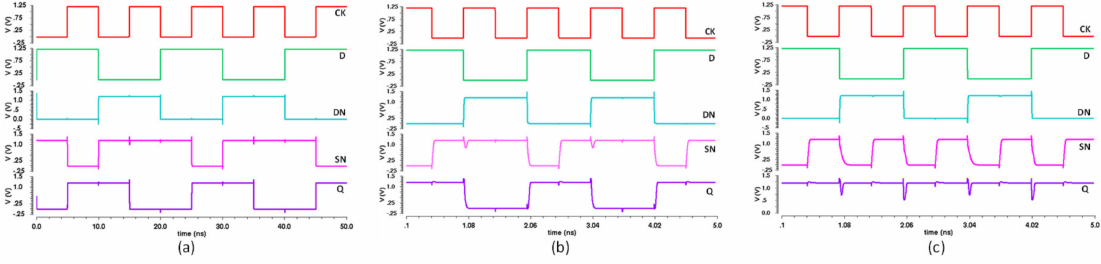
Figure 9. Transient waveforms of the proposed SAFF: ( a ) CK period = 10 ns, setup time = 5 ns; ( b ) CK period = 1 ns, setup time = 0; ( c ) CK period = 1 ns, setup